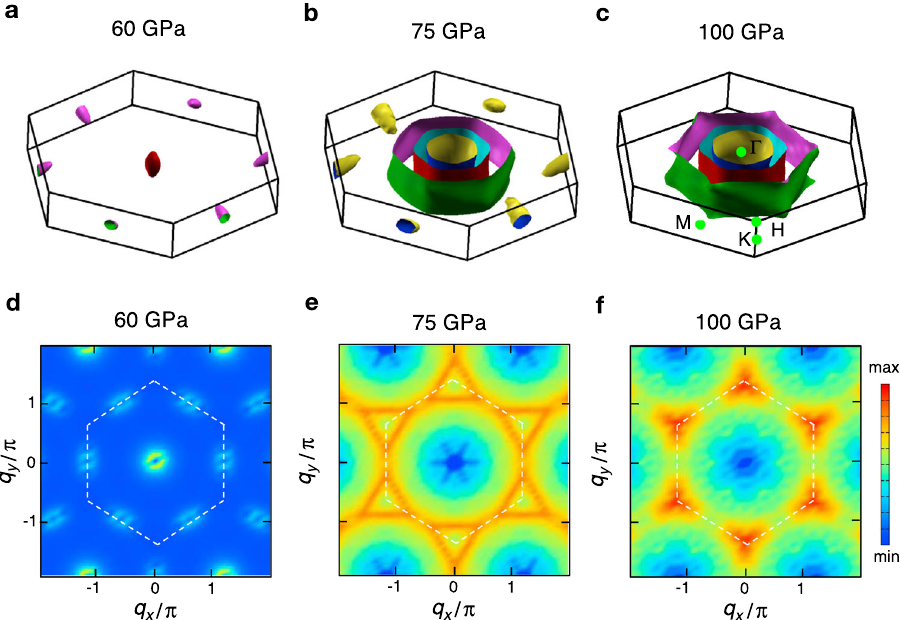
Fig. 4 Fermi surface topology and nesting with pressure. a – c Comparison of the DFT + DMFT calculated Fermi surfaces at 60, 75, and 100 GPa obtained at 10 K. d – f The corresponding Lindhard susceptibility (real part), showing a good nesting property only beyond 100 GPa.